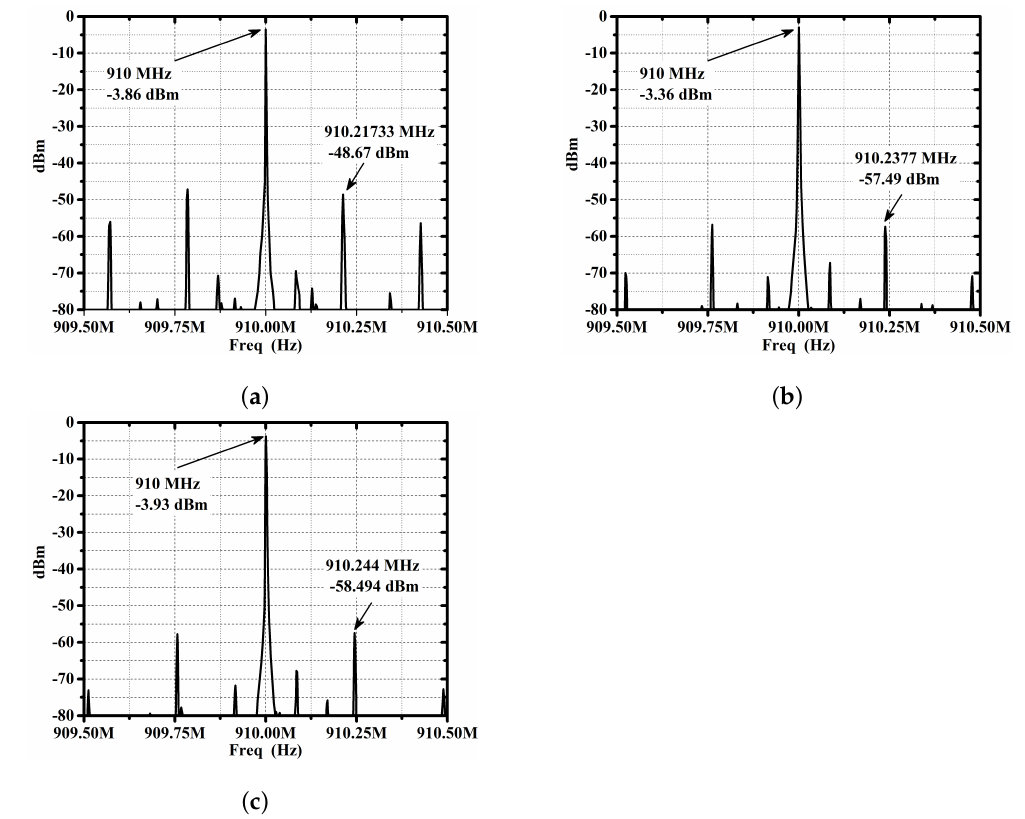
Figure 33. Measured lateral sidebands by applying different temperatures in the proposed sensor. ( a ) Lateral sidebands generated at 35.75 °C. ( b ) Lateral sidebands generated at 62.5 °C. ( c ) Lateral sidebands generated at 72